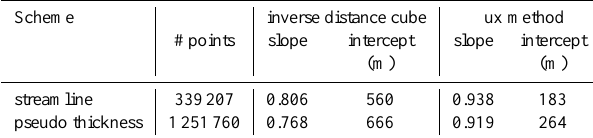
Table 1. Skill of the methods. The slope and intercept of the linear fit of estimated ice thickness as a function of observed ice thickness averaged over exclusion radii of 5–150 km as detailed in Sect.